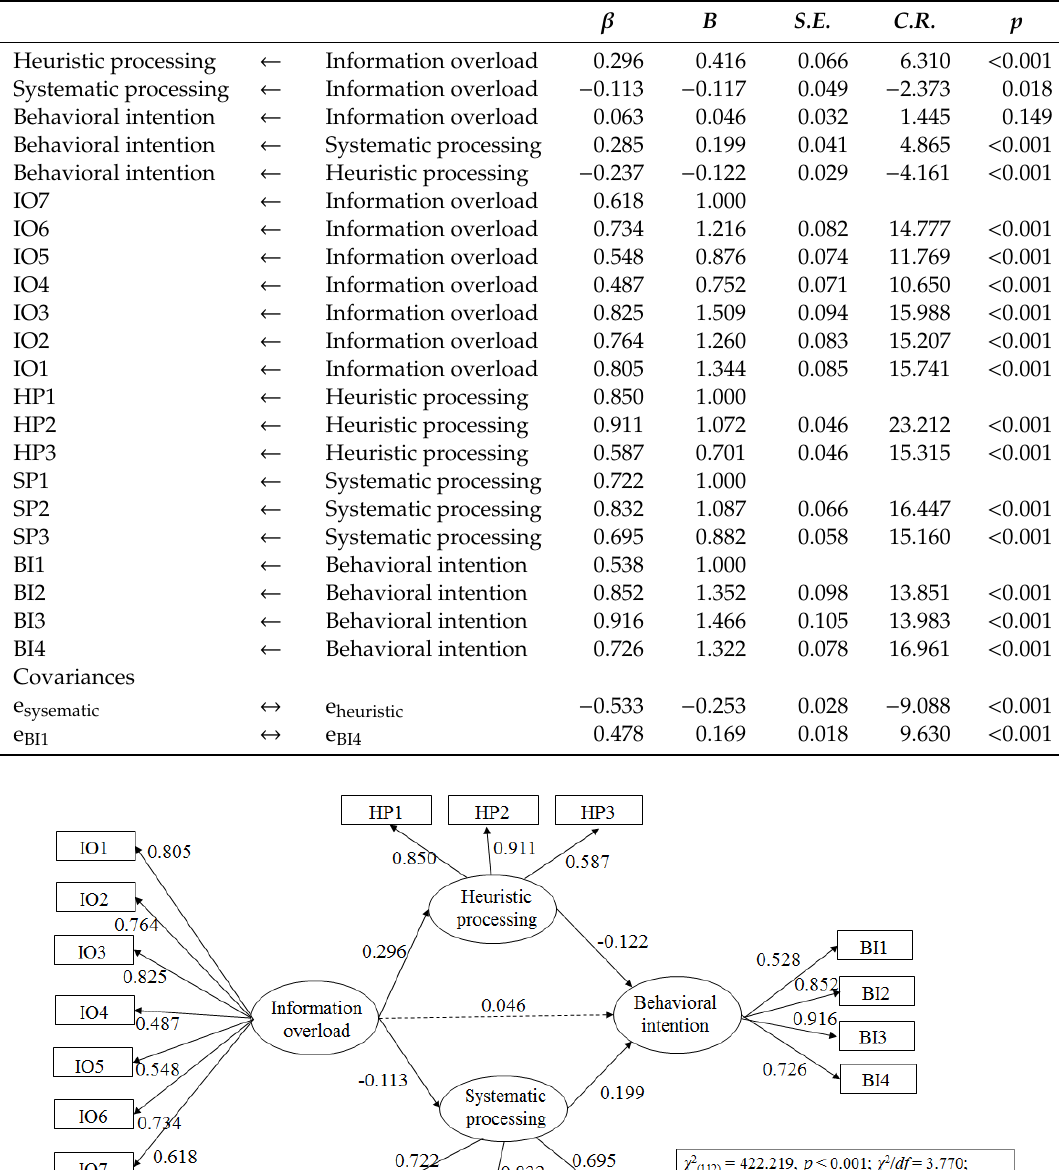
Table 2. Results of structural equation modeling.